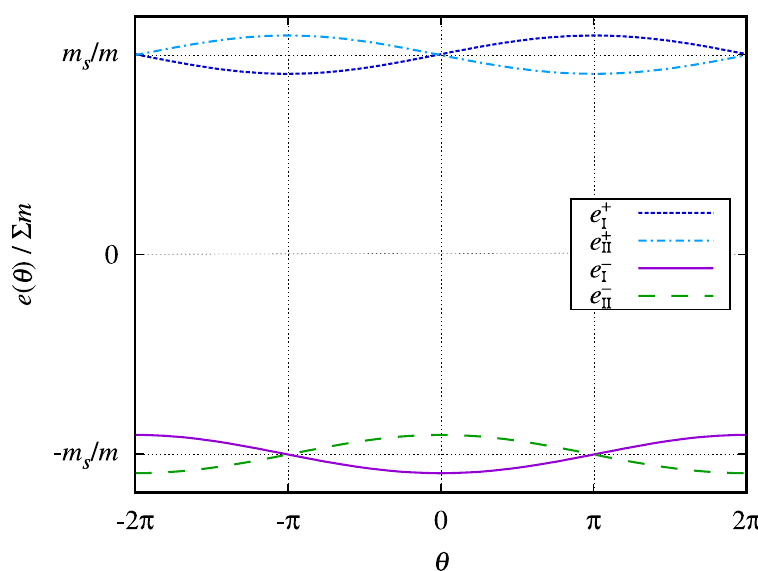
Figure 3 . Basic stationary points of V (cid:6) ( (cid:18); (cid:11) ). For details, see the